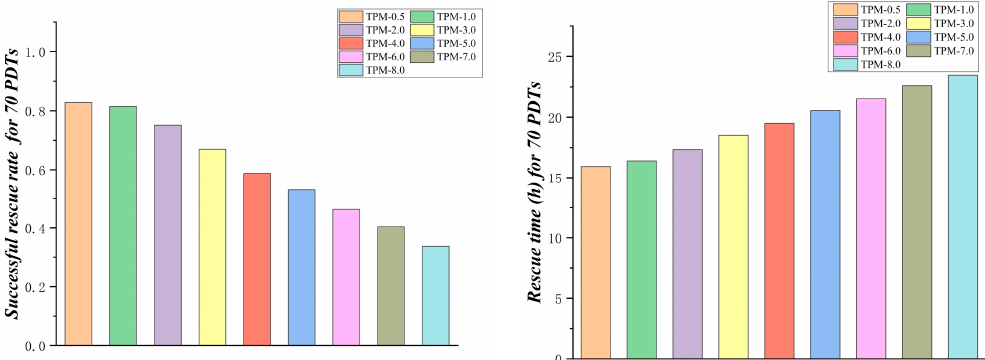
Figure 18. Successful rescue rate and rescue time for 70 PDTs with delay time from 0.5 h to 8.0 h.